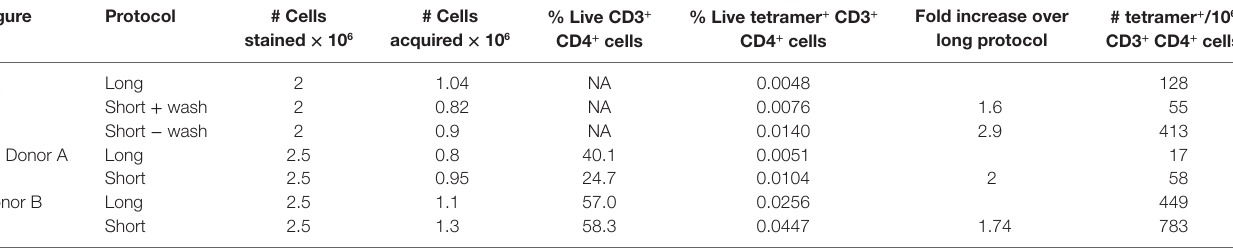
tAbLe 2 | Recovery and identification of tetramer + cells after short and long staining protocols.